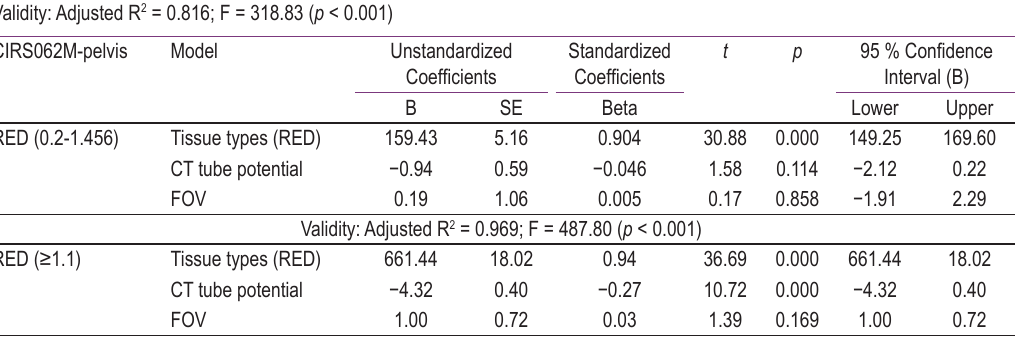
FIGURE 4. Computed tomography-relative electron density obtained by the computerized imaging reference systems 062M pelvis phan- tom, for different tube potentials (80 kV, 100 kV, 120 kV, and 140 kV) and field of view size 25 cm and 50 cm. TABLE 3. Multiple linear regression analysis (CIRS 062M-pelvis), effect of the CT tube potential and FOV on the mean HU values, for RED values 0.2-1.456 and just for